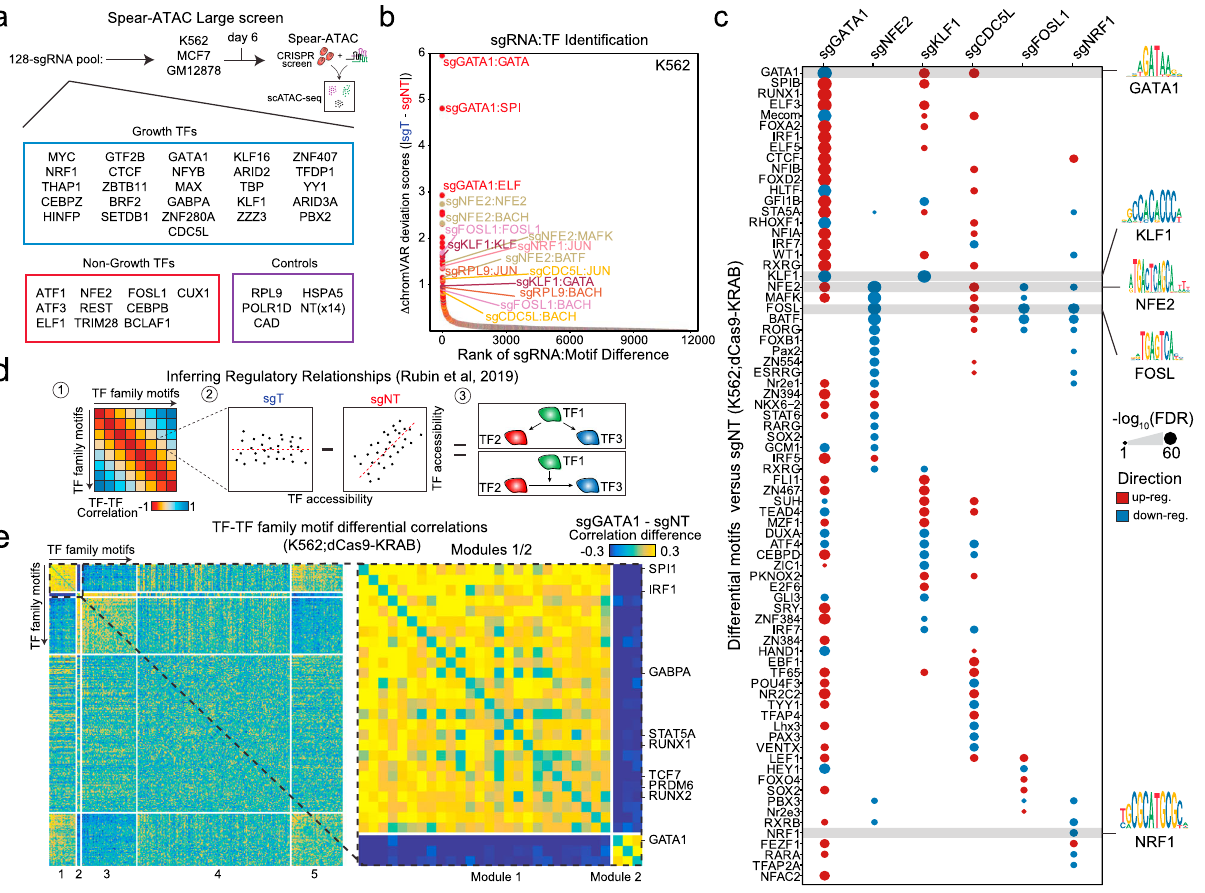
Fig. 3 High throughput chromatin accessibility screening of CRISPR perturbations using Spear-ATAC. a Schematic of Spear-ATAC large screens with a 132-sgRNA pool analyzed for three different cell lines (K562, MCF7, and GM12878). b Rank ordered plot of sgRNA:TF perturbations to identify top hits in the K562 large screen. c Motif enrichment in differentially accessible peaks across 6 perturbed transcription factors in the K562 large screen. Color indicates whether the motif enrichment corresponds to up-regulated (red) or down-regulated (blue) peaks. d Schematic of inferring regulatory relations with Spear-ATAC. Brie fl y, the correlation for each TF – TF motif is determined in both the targeting (sgT) and non-targeting (sgNT) cells. Next the correlation in the non-targeting cells is subtracted from targeting cells. These TF – TF motif pairs are then assessed for different regulatory relationships. e (Left) Heatmap of the differences between sgGATA1 targeting and non-targeting cells for all TF – TF motif accessibility correlations grouped into fi ve different modules in the K562 large screen. (Right) Zoomed-in heatmap of modules 1 and 2 highlighting transcription factors with largely perturbed TF – TF motif accessibility